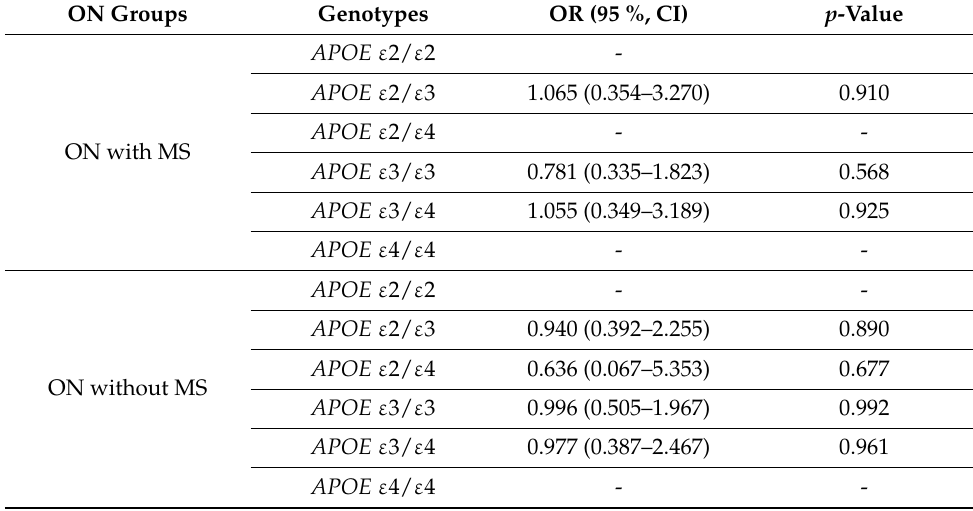
Table 7. APOE binary logistic regression in patients with ON with MS and without MS.